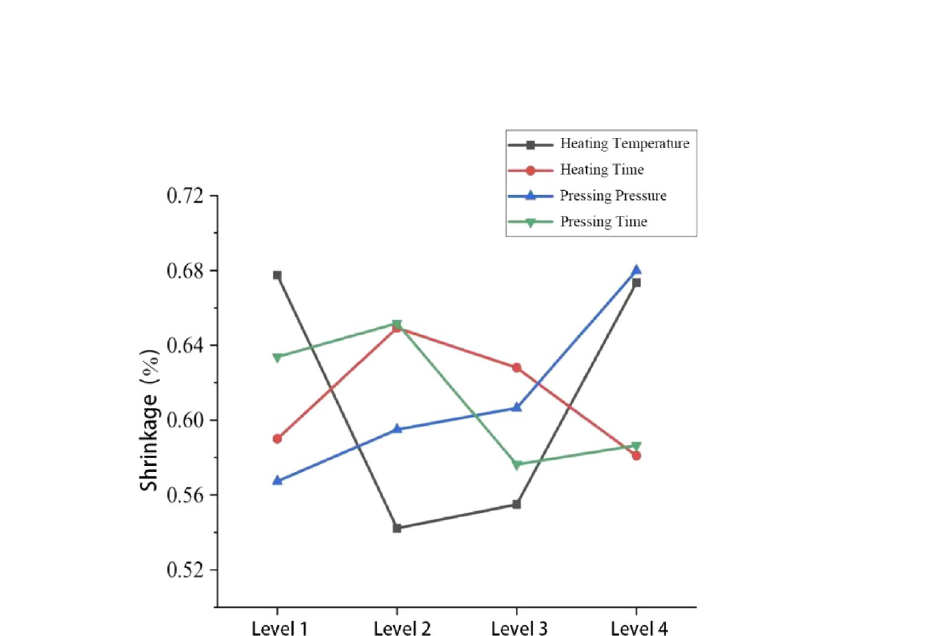
Figure 13. The degree of influence of each parameter on the shrinkage